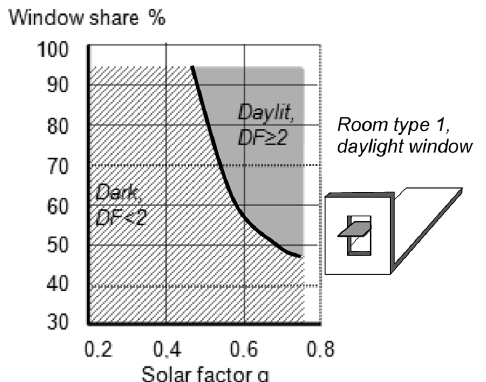
Fig. 6. Possible combinations of window glass share and solar factor for room type 1 that meet the requirement for a daylight factor (DF) ≥ 2